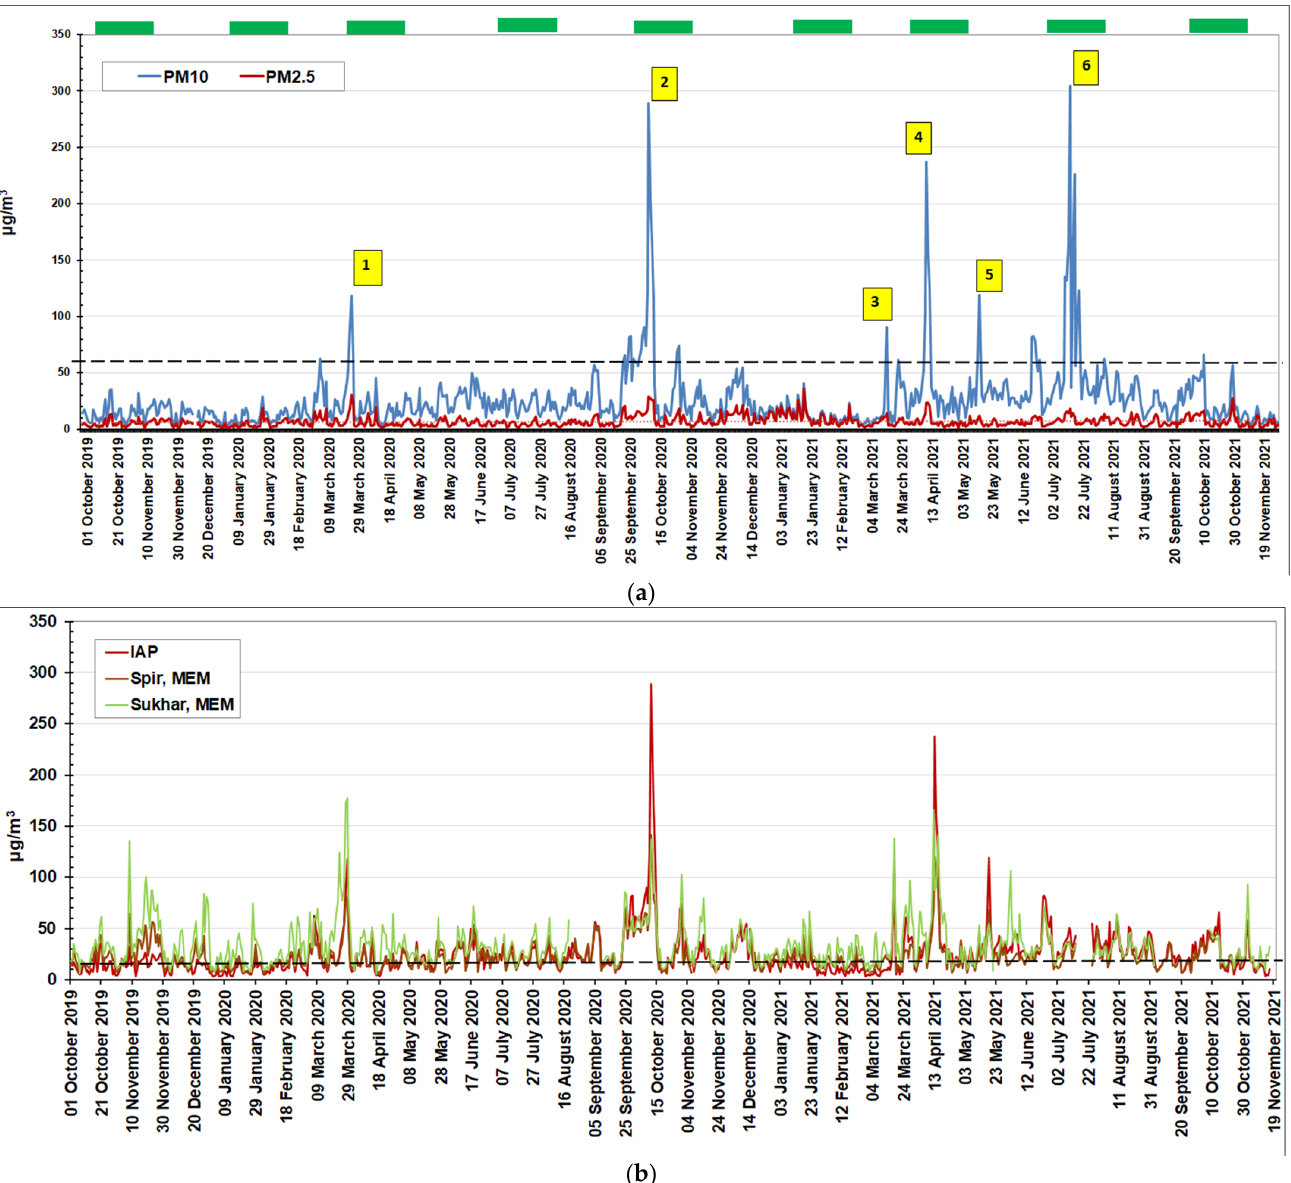
Figure 2. Average daily values of PM 10 and PM 2.5 particles mass concentration in near-surface air in Moscow during two years of continuous monitoring: ( a ) (upper figure)-selection of episodes for analysis (yellow squares 1–6), green segments at the top–periods of intensive monitoring with determination of aerosol elemental composition; ( b ) (lower figure)-comparison with the results of monitoring at the MEM stations (Spiridonovka and Sukharevskaya). Dashed lines are the daily MPC value for PM 10 particles in the air of residential